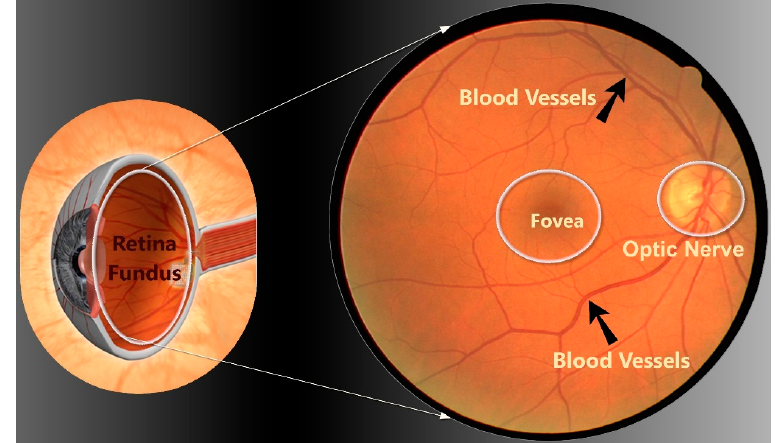
Figure 2. Retina fundus as seen through fundus camera.